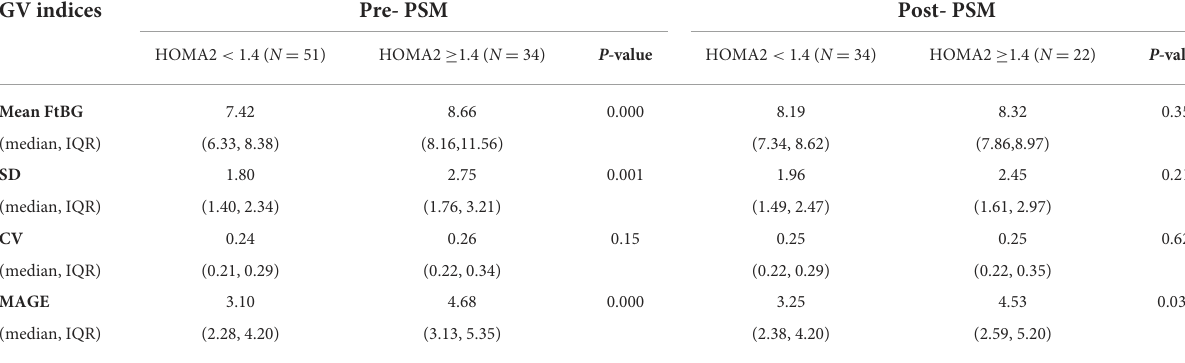
TABLE 2 The comparison of Glycemic Variability Indices between the two groups before and after